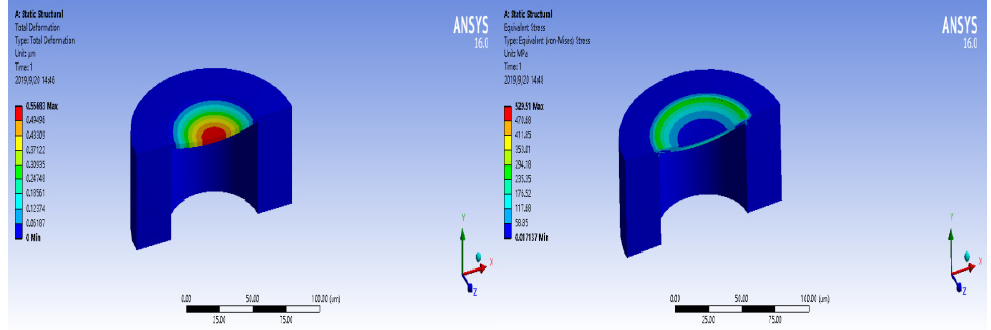
Figure 7. Stress and deformation of thin film under external pressure.